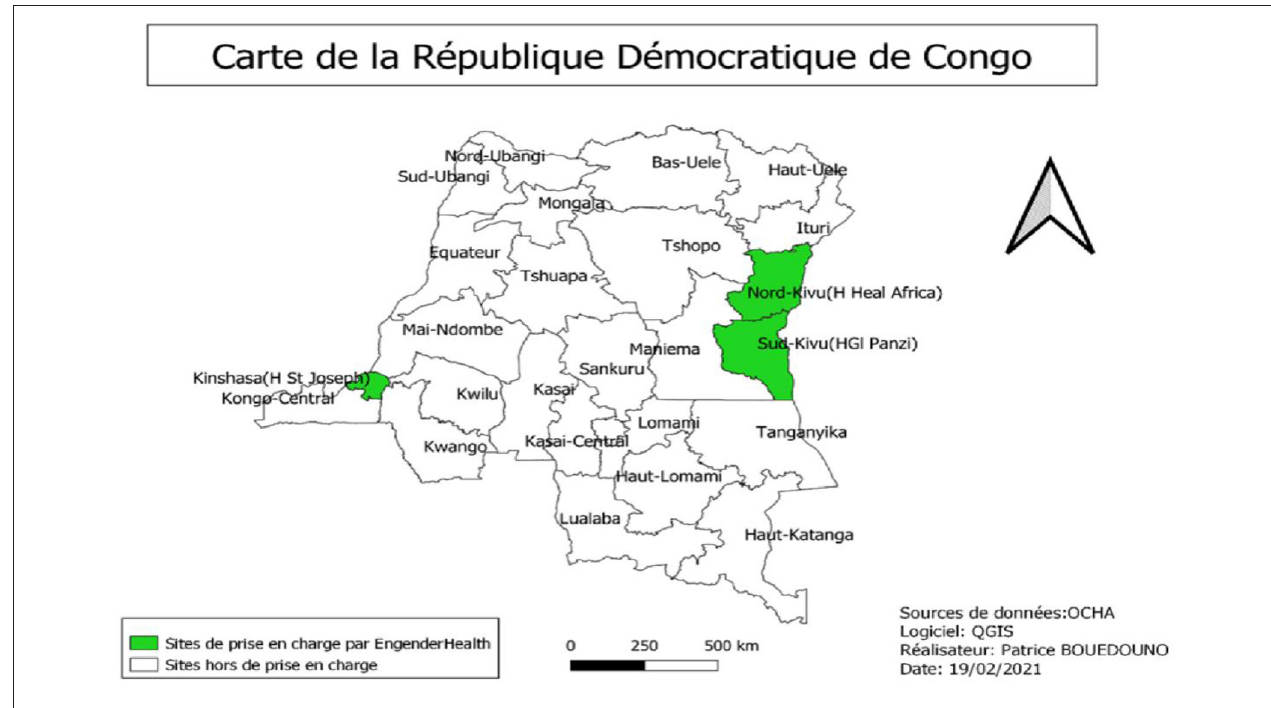
FIGURE 1 | Map of the DRC with study sites.